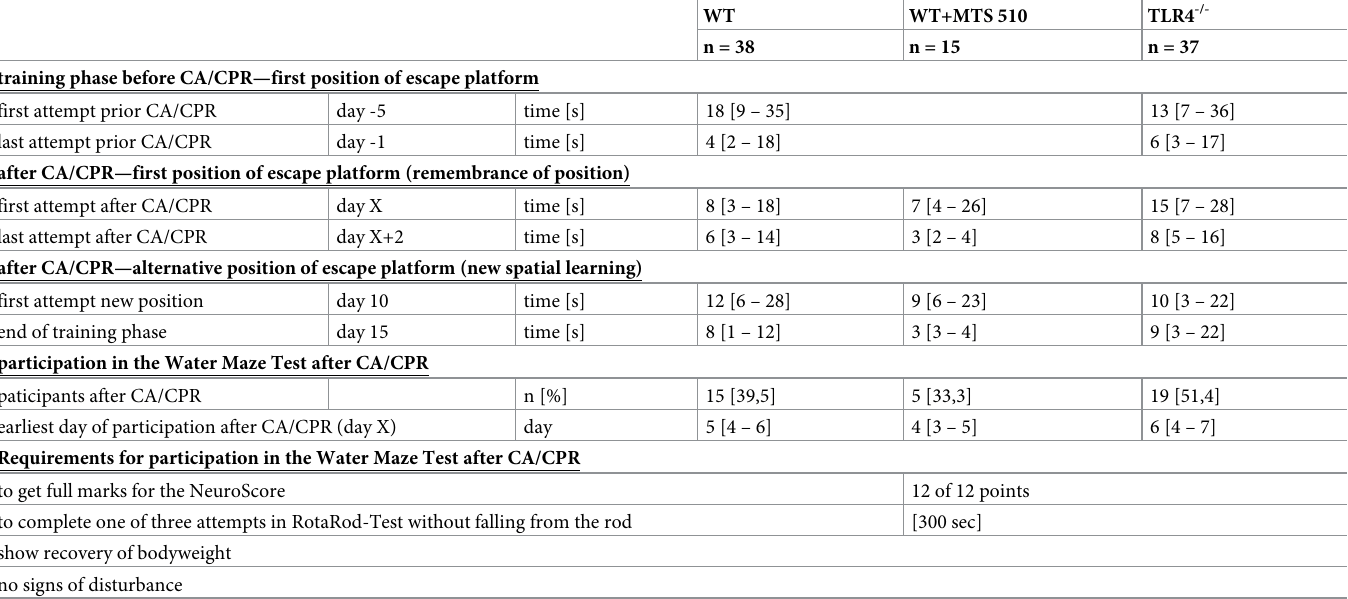
Table 4. Water maze